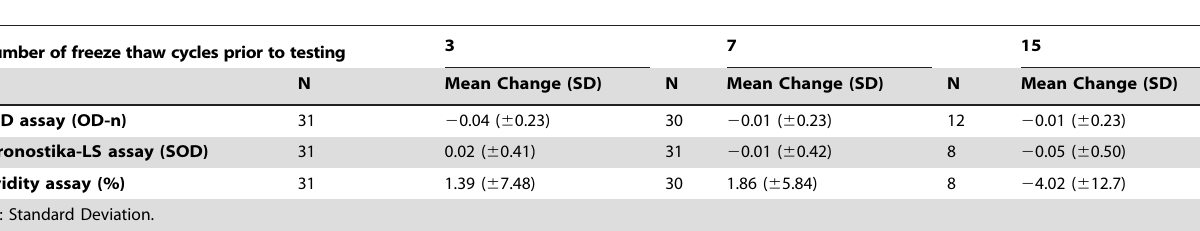
Table 2. Mean Change in Assay Results by Number of Freeze Thaw Cycles Prior to Testing.